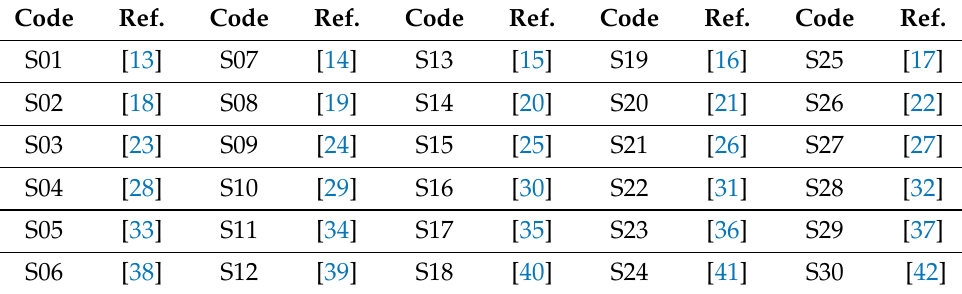
Table 2. List of papers selected.